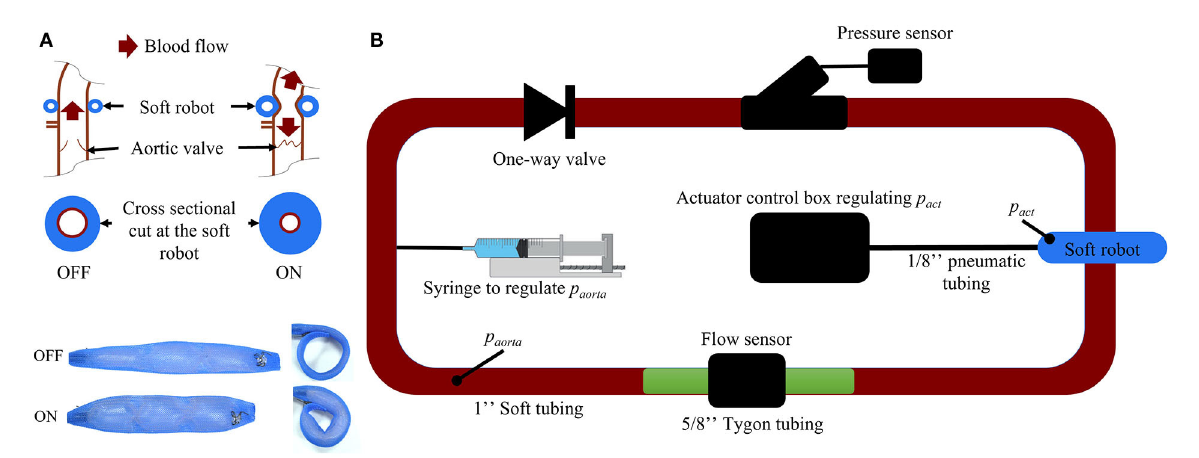
FIGURE3 (A) Working mechanism of the soft robotic McKibben actuator on the ascending aorta. (B) Passive flow loop for the soft robot characterization [ p aorta , pressure inside the passive loop (mmHg); p act , pressure inside the soft robot